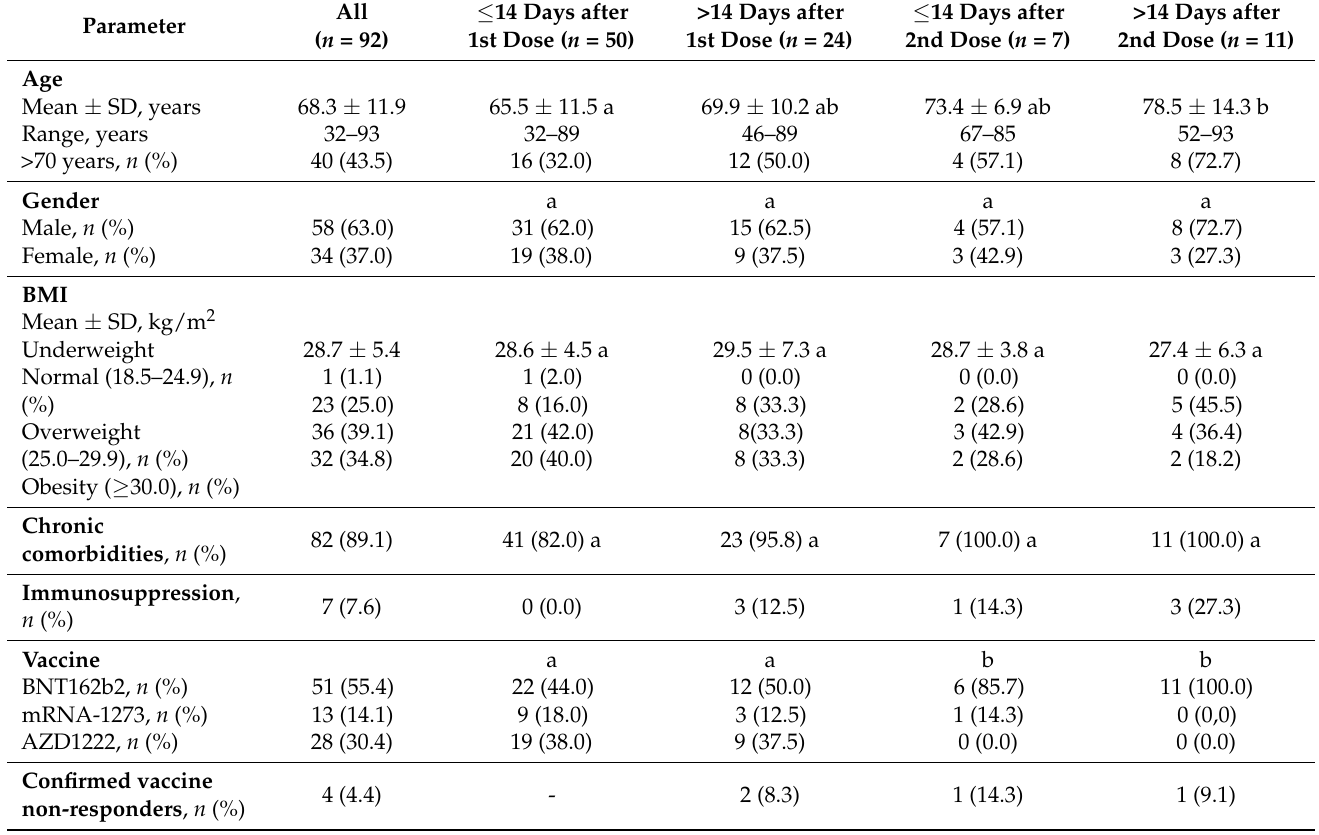
Table 1. The demographic breakdown of COVID-19 patients who have previously received at least one dose of COVID-19 vaccine ( n = 92). Different letters in each row indicate statistically significant differences between the sub-groups ( p < 0.05) demonstrated with the post hoc Dunn’s test following the Kruskal–Wallis ANOVA or with the Pearson’s χ 2